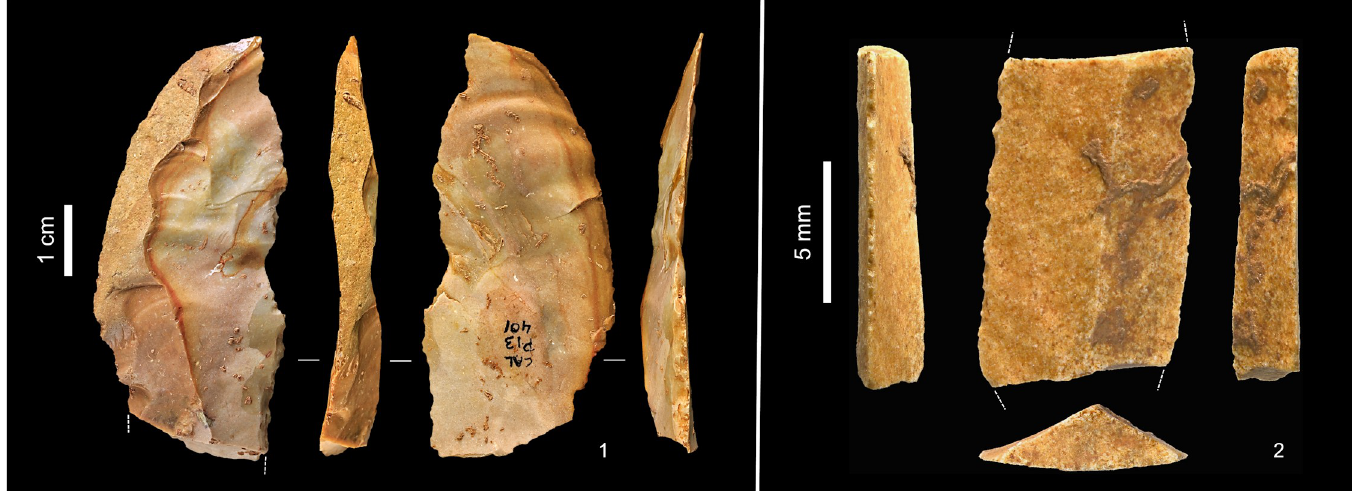
Fig 10. Chert tools from layers Jb-L. 1. Unilaterally retouched, naturally backed blade (P13-401, top of layer K). 2. Dufour bladelet, mesial fragment (P11sc980, top of layer